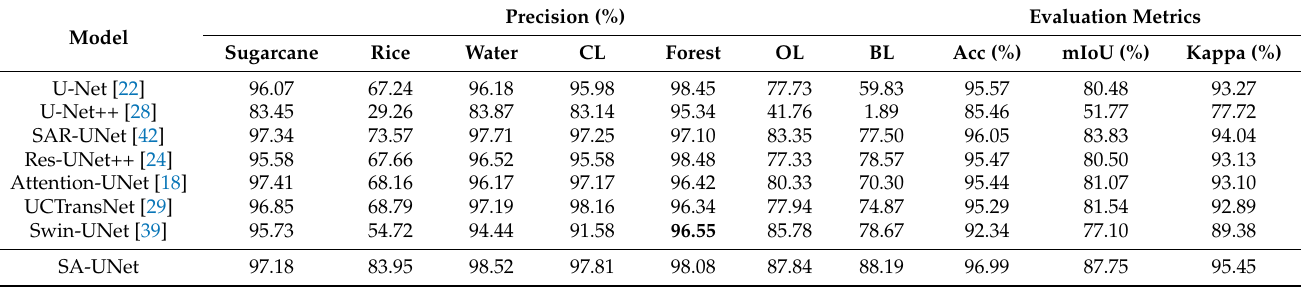
Table 7. Comparison of segmentation results of test sets in the 2015 dataset I by different methods. Model